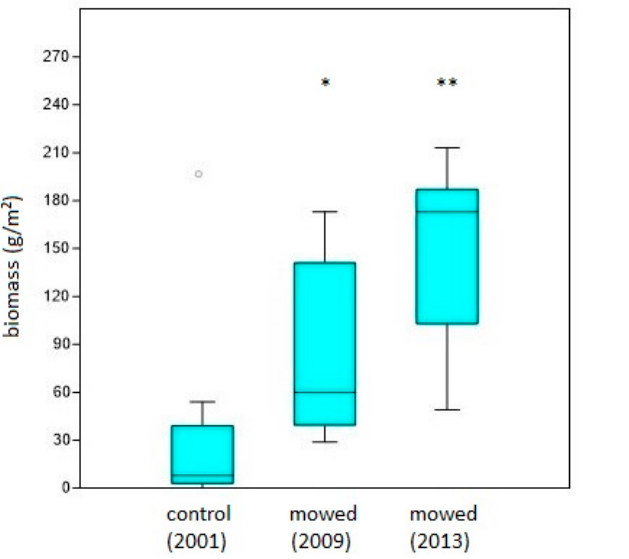
Figure 5. Biomass of Fabaceae species in selected mown and control plots. * p < 0.05, ** p < 0.01. The empty circle indicates the outlier.